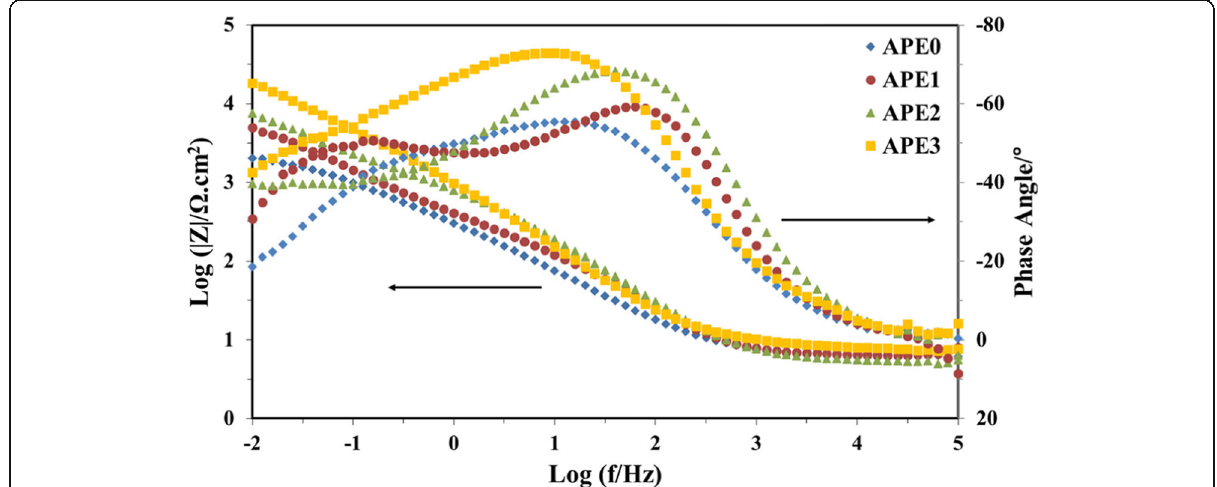
Fig. 5 Bode curves for steel samples after 7-day immersion in NaCl brine containing 0 to 3% (v/v)